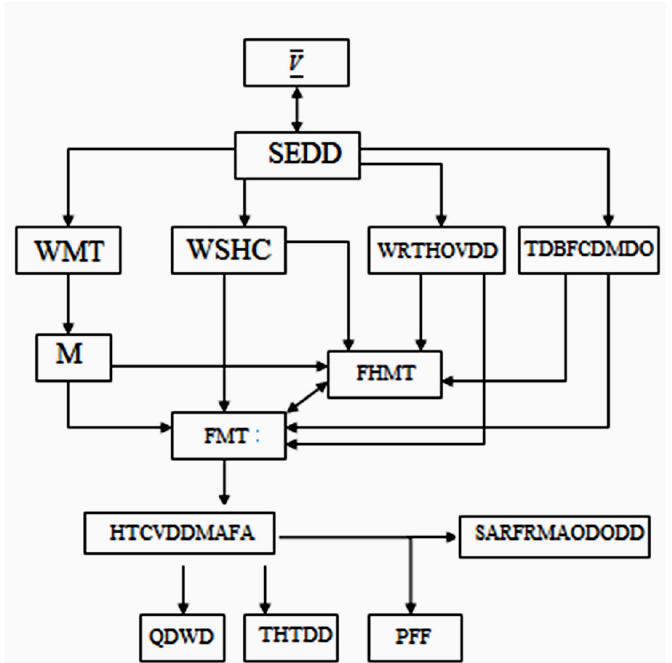
Fig. 5. Block diagram (V) of the hierarchy level of the system analysis of the degreasing process of raw materials of animal